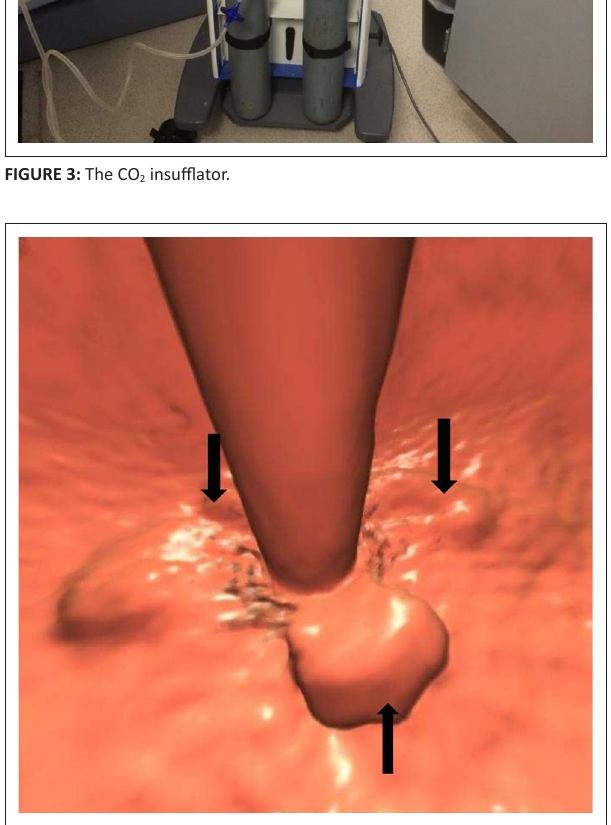
FIGURE 4: Large internal haemorrhoids (arrows) visualised when the balloon is